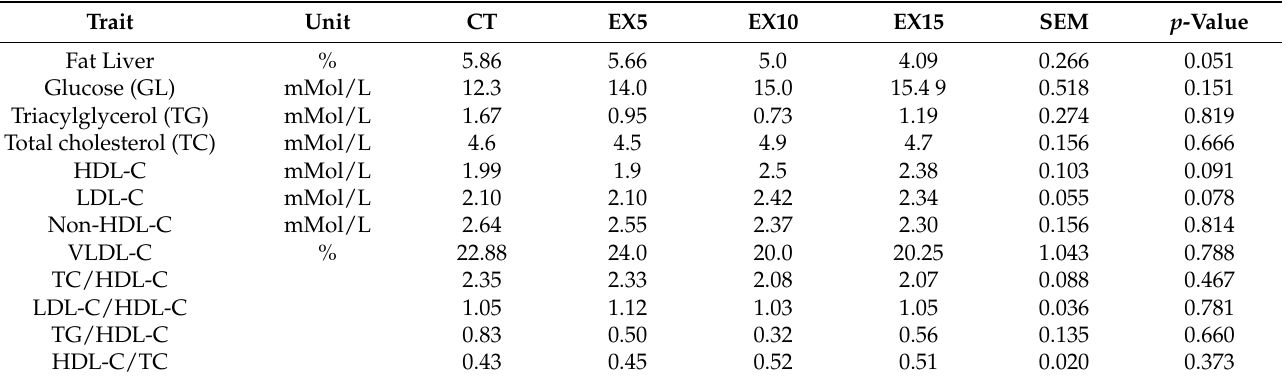
Table 6. Fat content in the liver and selected parameters carbohydrate-lipid metabolism in the blood serum of male 43-day-old Ross-308 broilers (Mean, SEM, n =